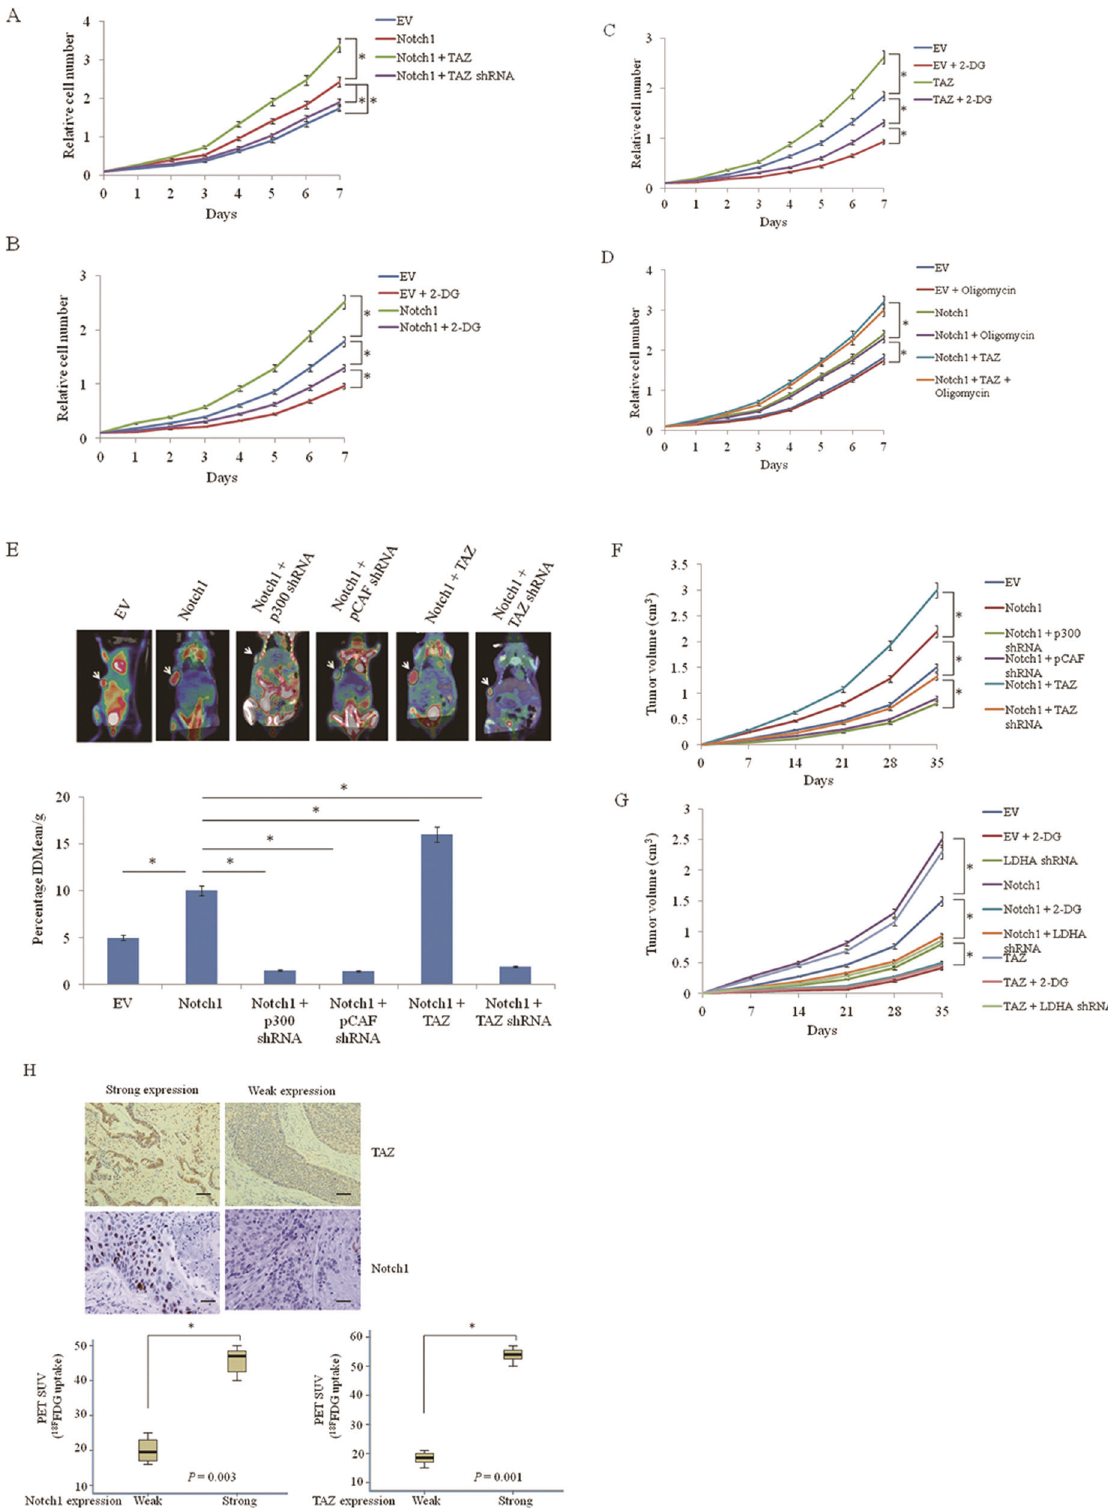
of Jagged1 that is activated by TAZ. Comparative sequence analysis of the Jagged1 genomic locus identi fi ed 15 evolutionarily conserved regions (ECRs). A single Jagged1 ECR, located